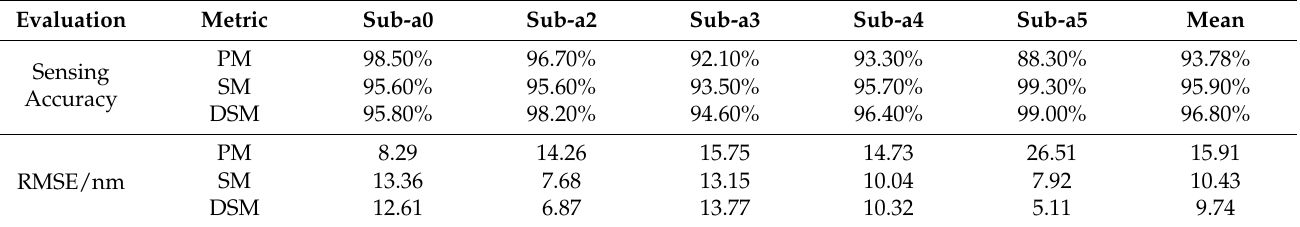
Table 4. The test results of the five sub-apertures that were based on different metrics .